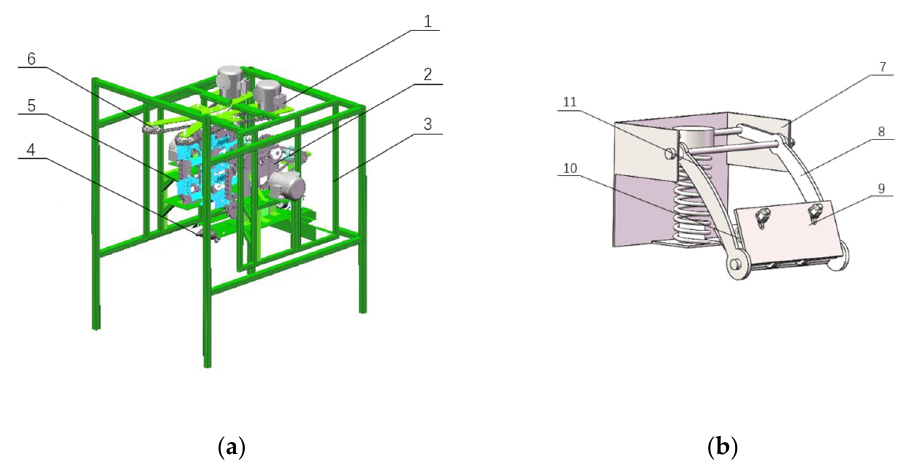
Figure 1. Reverse flexible earing device for fresh corn. ( a ) Overall structure of ear picking device; ( b ) flexible ear picking claw structure. 1. Motor. 2. Inner frame. 3. Outer frame. 4. Stem pulling de-